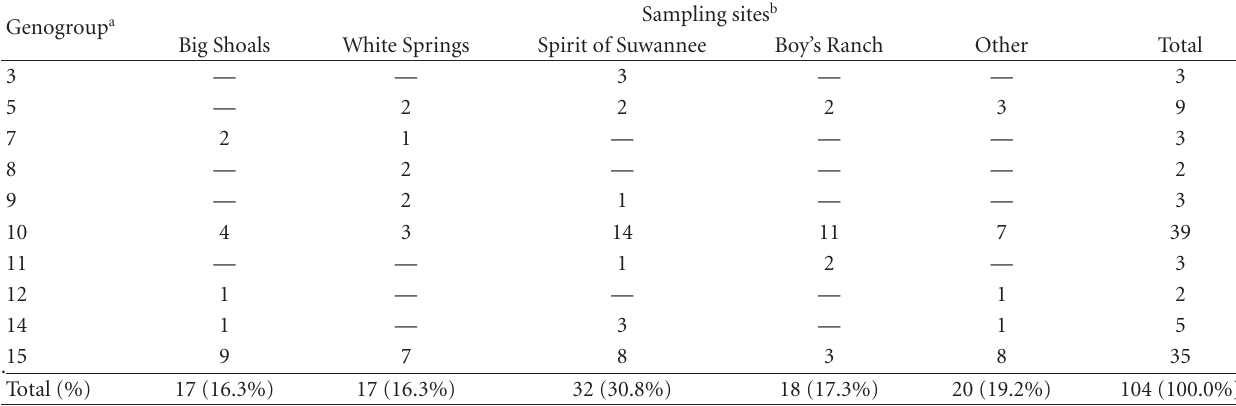
Table 3: Distribution of S. enterica genogroups by location for strains recovered from the Suwannee River. Genogroup